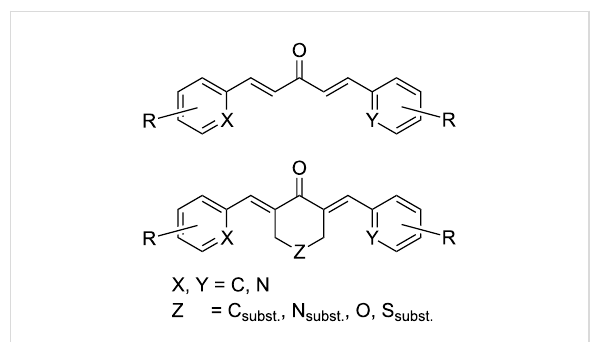
Figure 3: Backbone and substitution of monocarbonyl analogs of curcumin (MACs) showing their structural